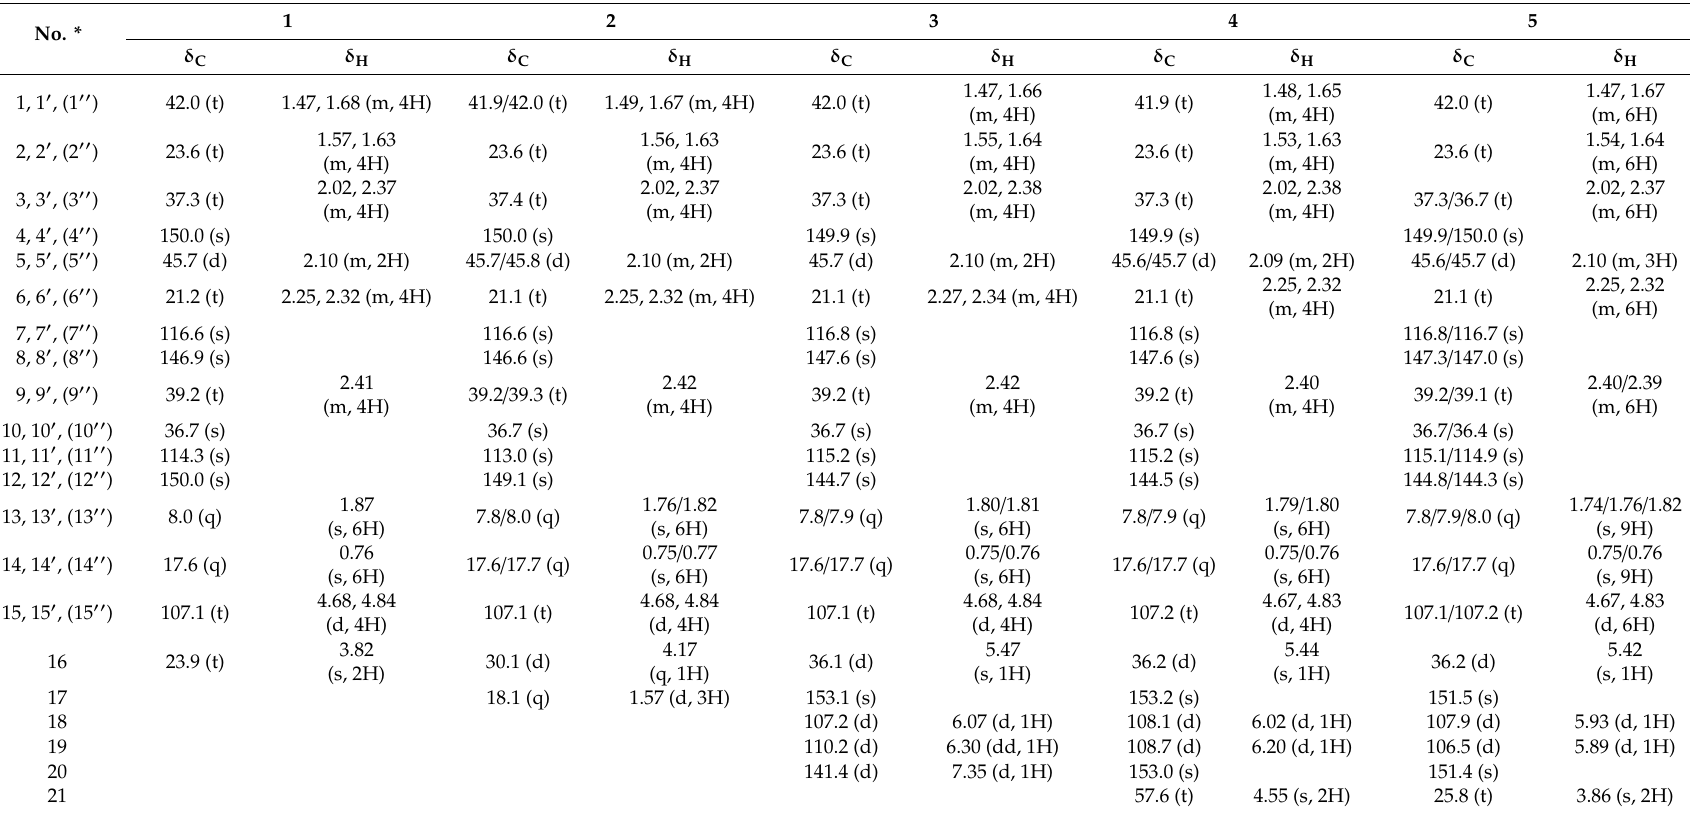
Table 1. 1 H-(500 MHz) and 13 C-(125 MHz) NMR data of compounds 1 – 5 (recorded in CDCl 3 ,